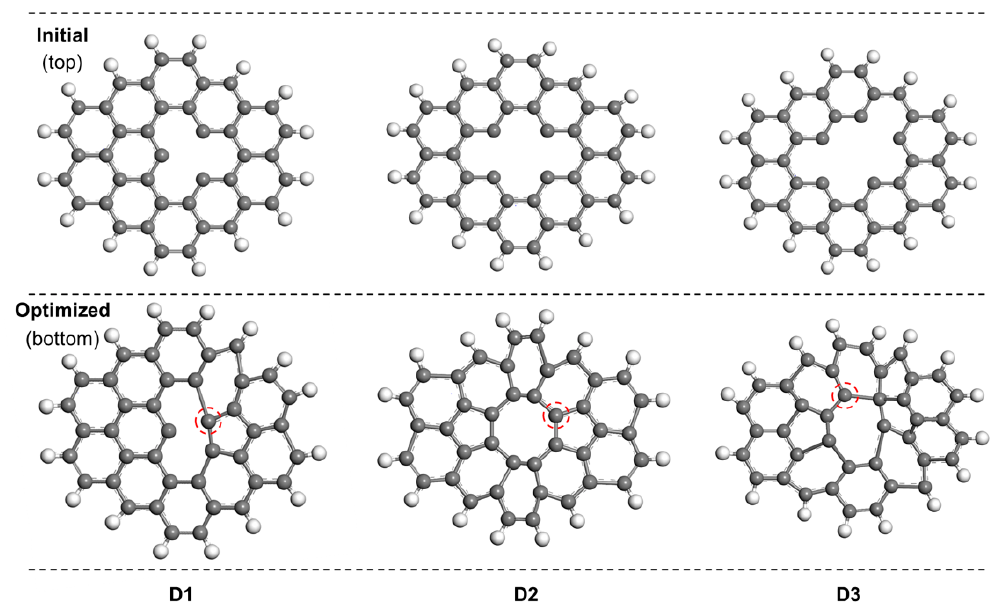
Figure 8. The structures for three typical defects (single defect ( D1 ), double defects ( D2 ) and triple defects ( D3 )) on graphene: The initial structures ( top ) and the optimized structures ( bottom ). Materials 2020 , 13 , x